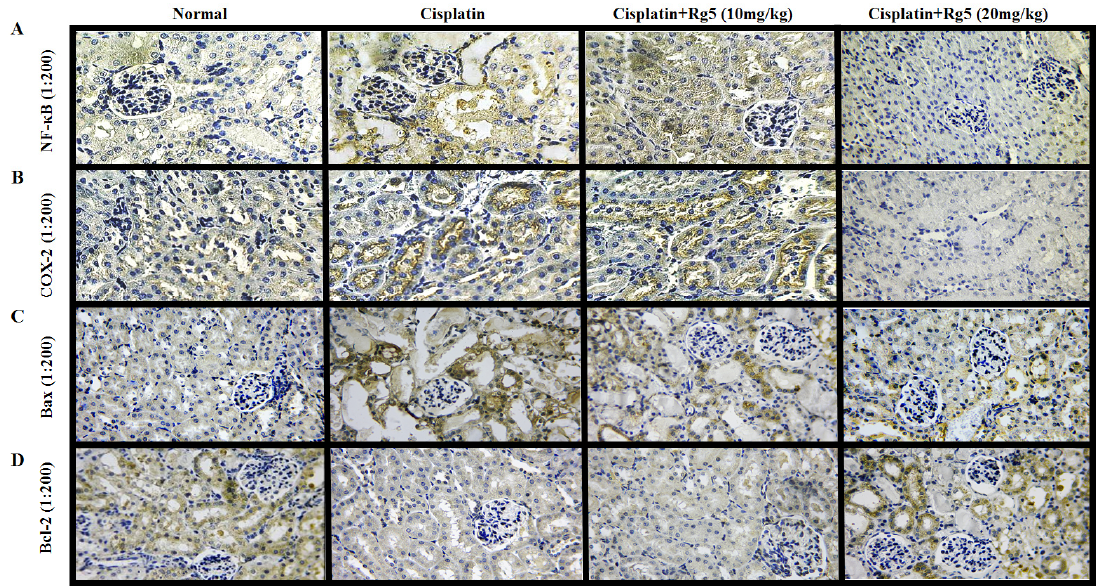
Figure 9. Effects of ginsenoside Rg5 on the expression of: nuclear factor-kappa B (NF- κ B) p65 ( A ); cyclooxygenase-2 (COX-2) ( B ); Bax ( C ); and Bcl-2 ( D ) ( × 200). The protein expression was examined by immunohistochemistry in kidney tissues from normal, cisplatin, cisplatin + Rg5 (10 mg/kg), and cisplatin + Rg5 (20 mg/kg).